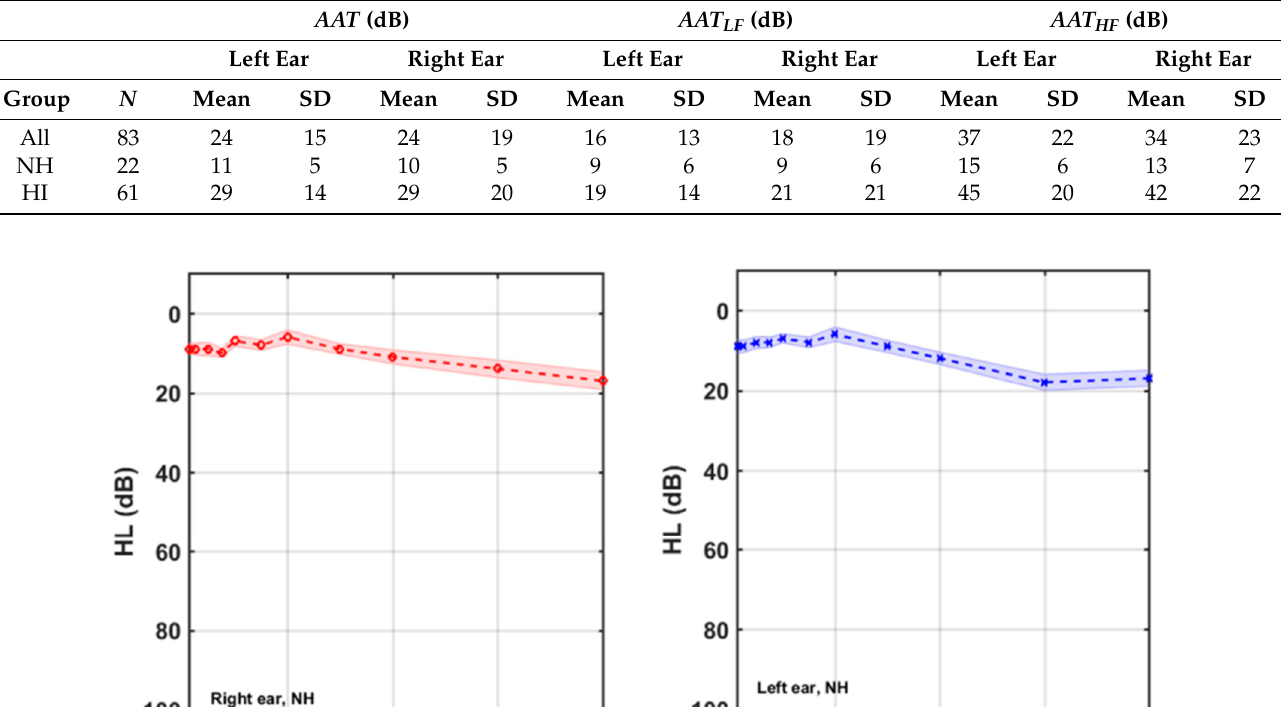
Table 2. Average audiometric thresholds ( AAT ) of patients by subgroups.